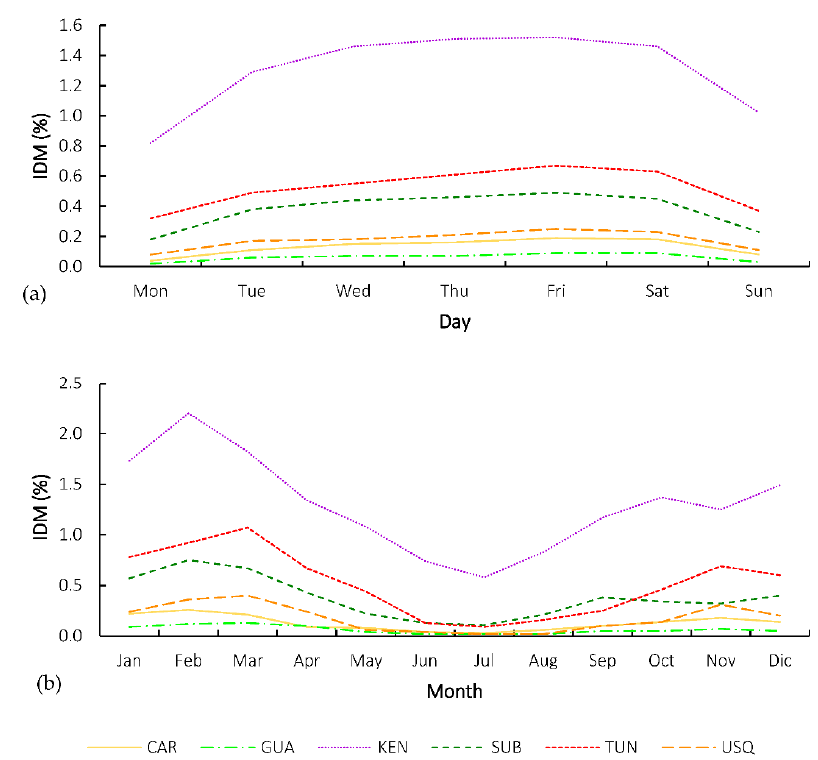
Figure 5. Temporal variation of ( a ) daily and ( b ) monthly IDM in Bogotá D.C.